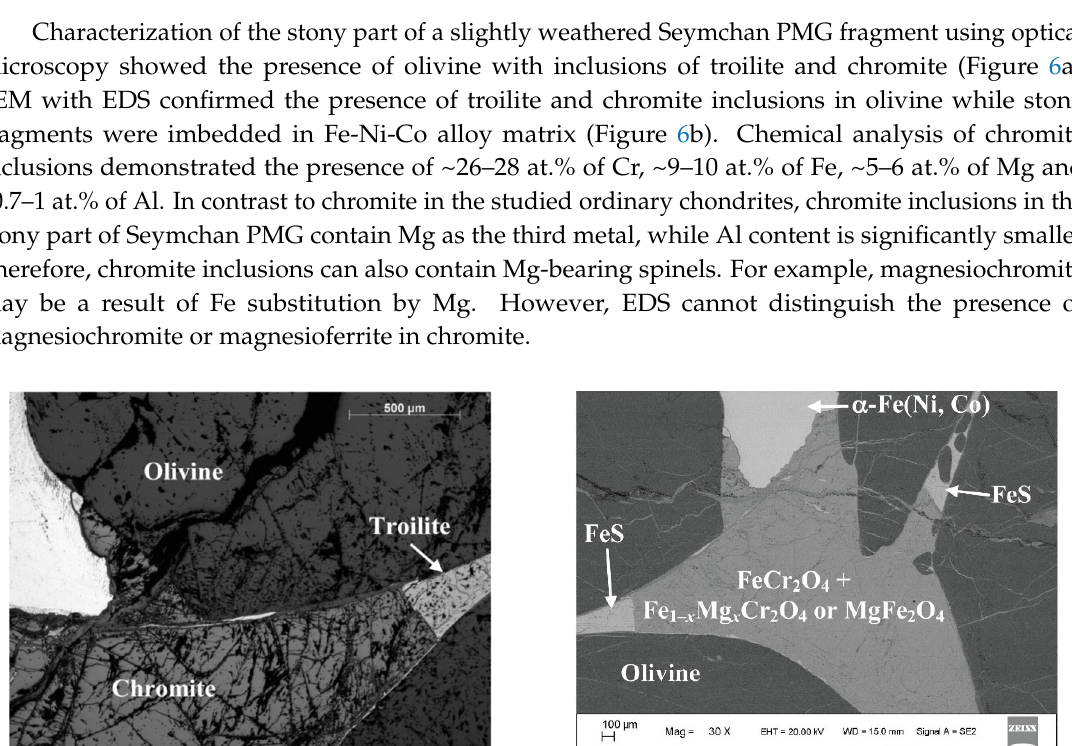
Figure 6. Characterization of the stony part of Seymchan main group pallasite: ( a ) optical microphotograph; and ( b ) scanning electron microscopy image with the results of energy dispersive spectroscopy. Adopted from [15].